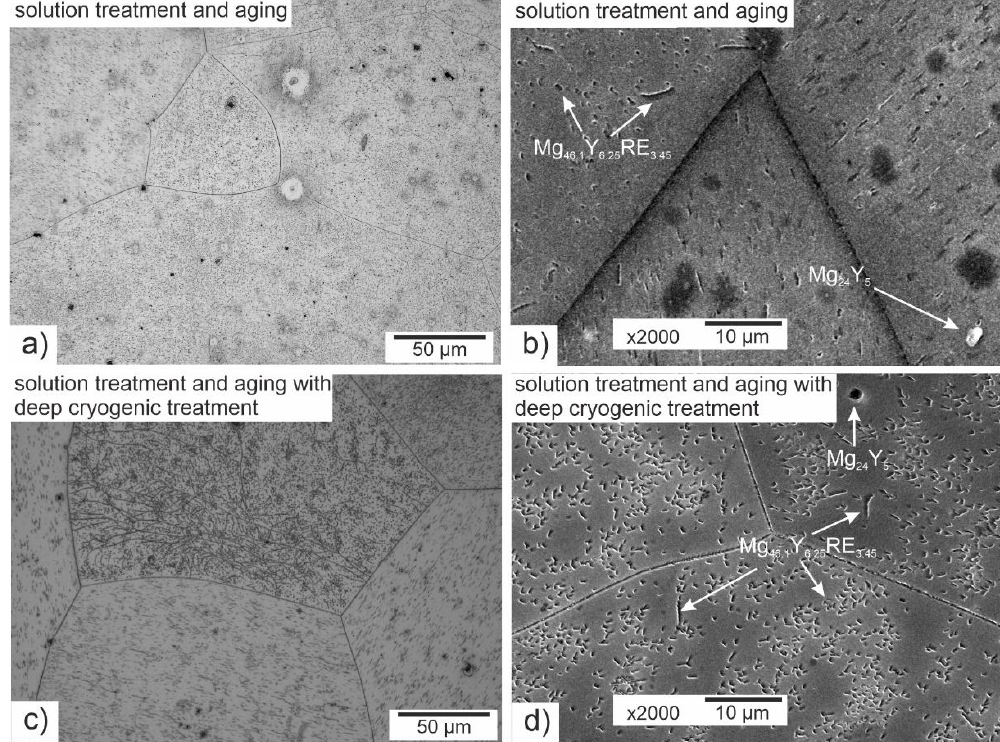
Figure 2. Microstructure of the Mg-Y-Nd alloy after precipitation hardening (solution treatment at 545 °C/8 h and aging at 250 °C/24 h) ( a , b ) and after precipitation hardening with a deep cryogenic treatment ( c , d ).